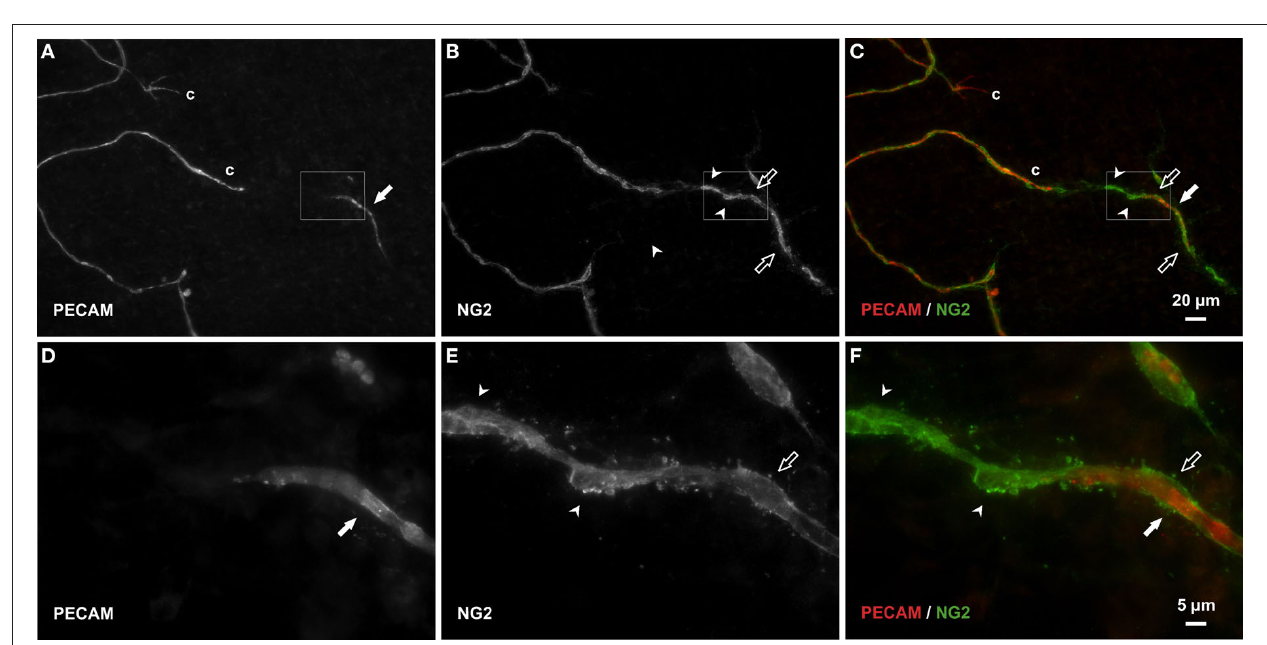
FIGURE 5 | Pericytes bridge and extend along vascular islands during regression. (A–C) Examples of PECAM-positive endothelial cells along vascular islands (filled arrows) with positive NG2 pericyte association. NG2 positive pericytes were observed associating with islands by either wrapping